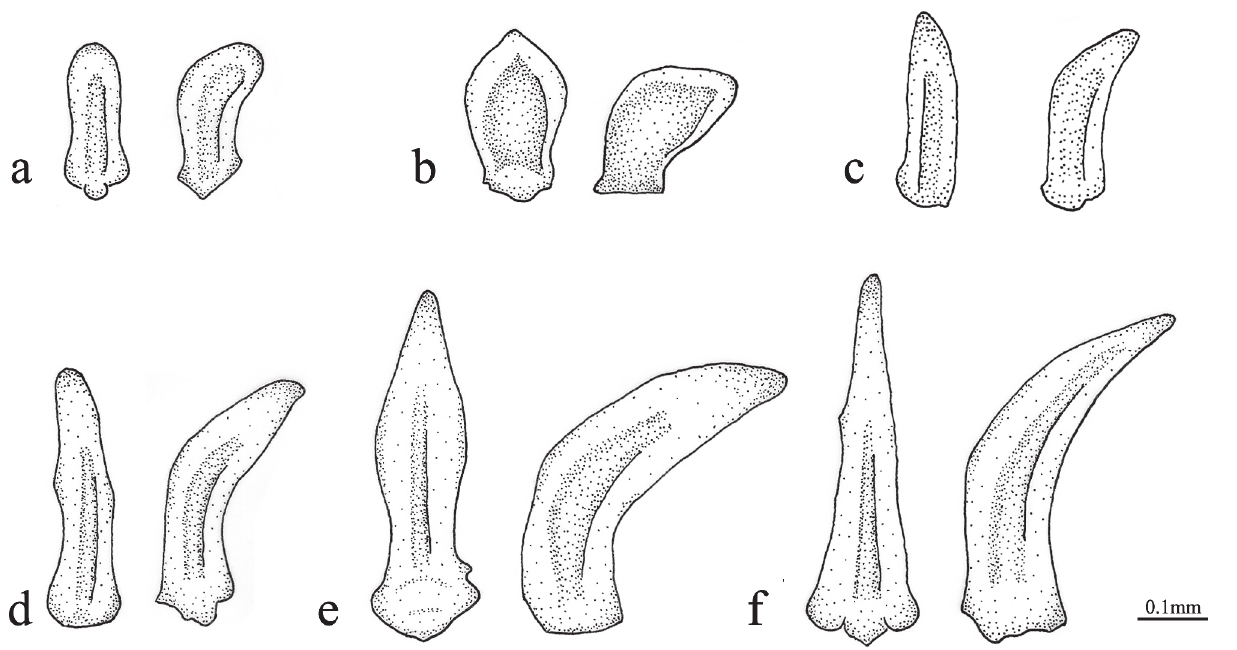
Fig. 2. Range of size and shape of odontodes on dorsal tip of rostrum. a . Microlepidogaster perforatus , MNRJ 31886, male, 30.6 mm SL. b . Microlepidogaster dimorpha , male, DZSJRP 8750, paratype, 29.3 mm SL. c . Microlepidogaster longicolla , female, DZSJRP 12435, paratype, 39.7 mm SL. d . Pseudotocinclus tietensis , DZSJRP 6940, female, 54.7 mm SL. e . Epactionotus bilineatus , DZSJRP 11358, female, 32.9 mm SL. f . Hisonotus depressicauda , DZSJRP 11422, female, 32.2 mm SL. Ventral (left) and lateral (right)